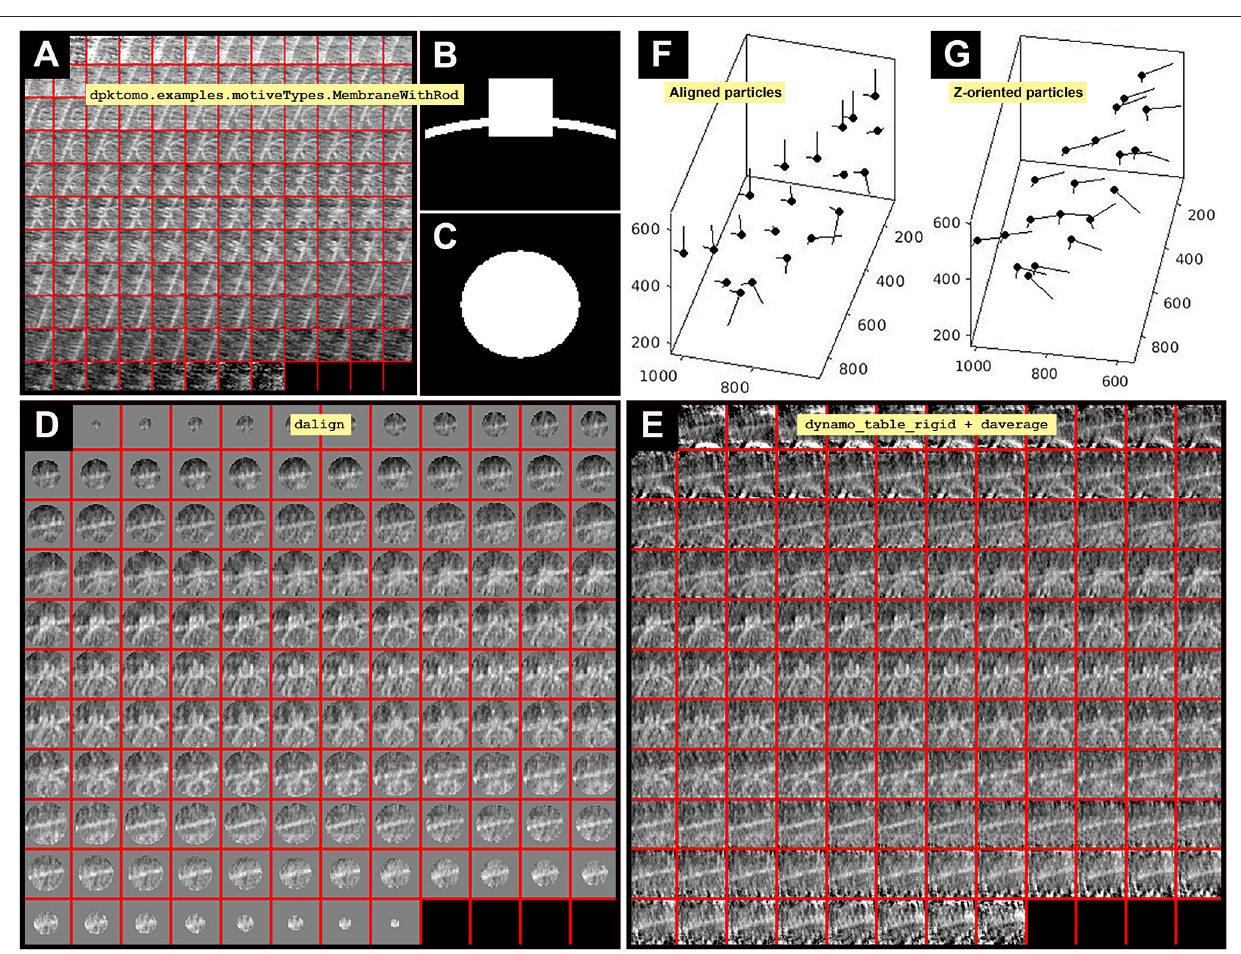
(e) view(-230,30);axis equal